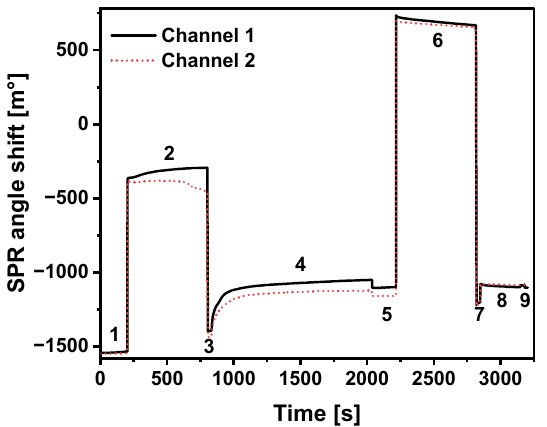
Figure 1. SPR study of CD44 immobilization in both channels of the MUA-modified SPR sensor